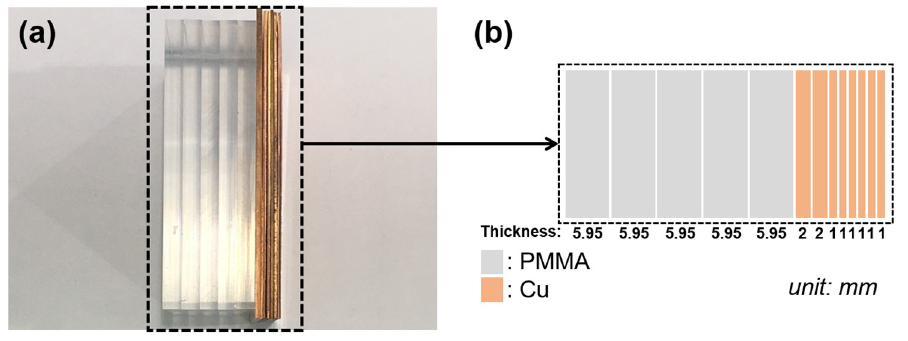
Fig 6. MD calibration phantom in the experiments. (a) Front view of the calibration phantom. (b) Schematic of the thickness combination of the PMMA and copper.